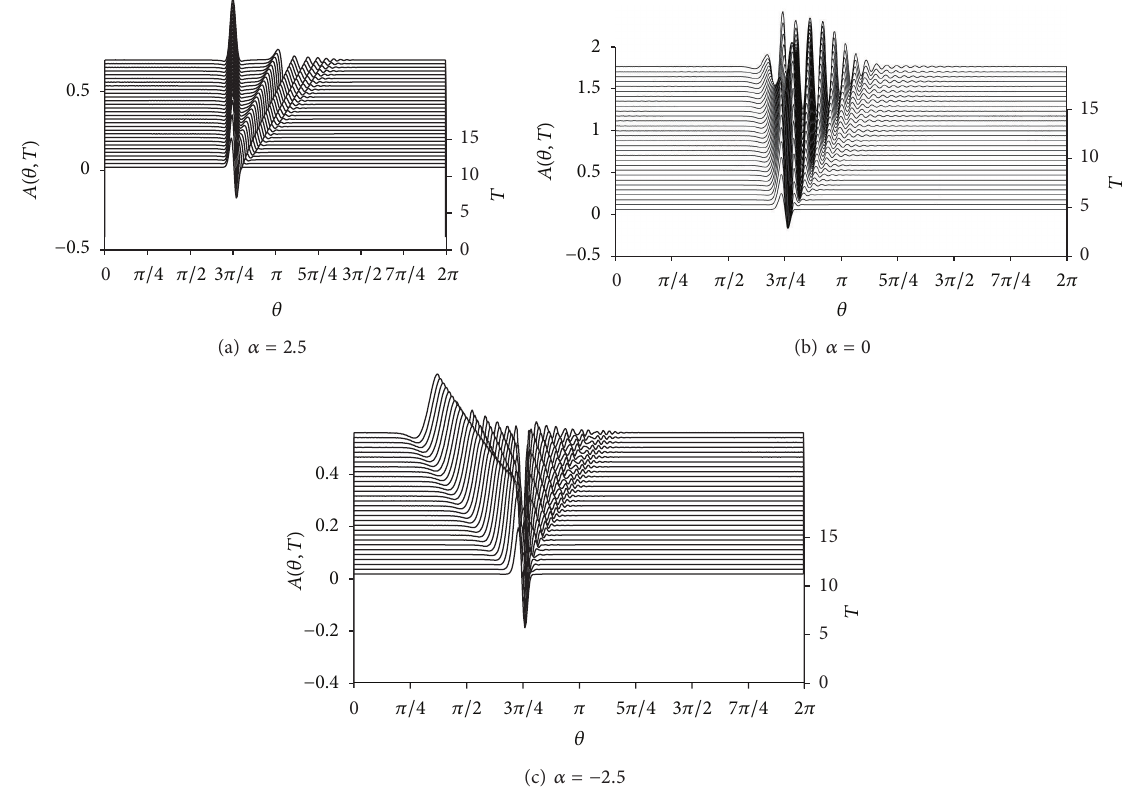
Figure 1: Solitary waves generated by topography in the absence of dissipation.